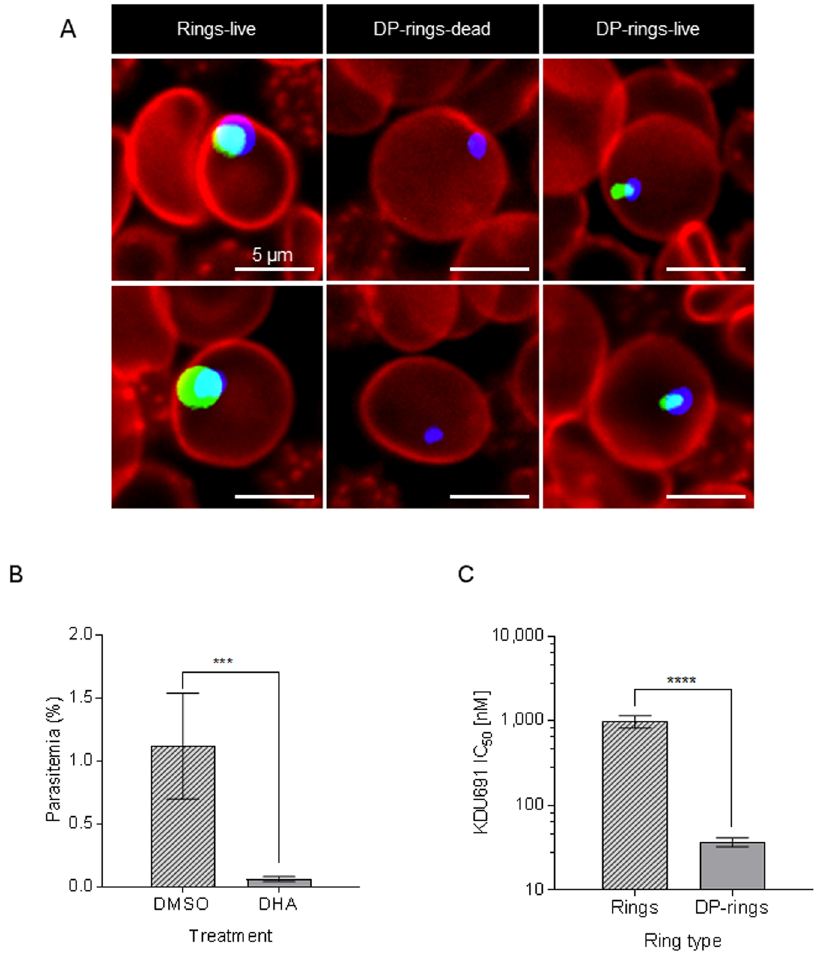
Figure 1. Rings pre-treated with DHA are sensitized to the PI4K inhibitor KDU691. ( A ) Determination of live (green-blue) and dead (blue) parasites by high content imaging (HCI) from rings (3–6 hours) and DP-rings (18 hours following 6 hours, 700 nM DHA treatment). Blue (DAPI): DNA; Green (MitoTracker ® Orange): functional mitochondria; Red: (wheat germ agglutinin (WGA) conjugated to Alexa Fluor ® 647): red blood cells. ( B ) Mean parasitemias are shown for ring-stage parasites at 24 hours after exposure to 700 nM DHA for six hours. ( C ) IC 50 of KDU691 against rings and DP-rings following treatment for 22 hours. In A and B live parasites were stained with Rhodamine 123 and quantified with flow cytometry. Data for B and C (means ± SEM) were calculated from three independent biological